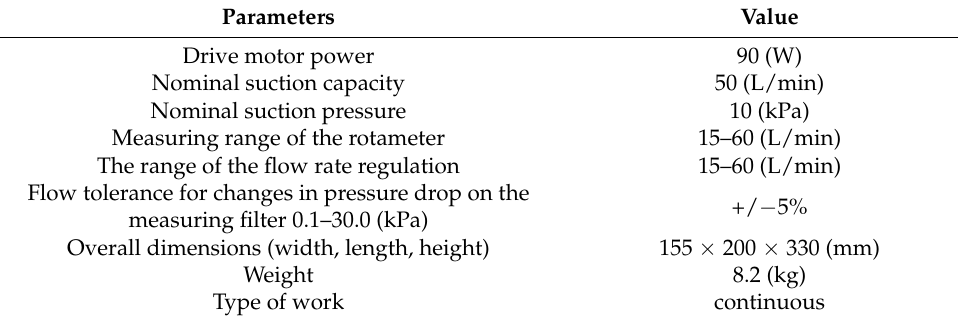
Figure 1. Salt-dust measuring instruments: ( a ) AS-50 gravimetric dust meter; ( b ) U-tube liquid manometer with Pitot–Prandtl probe. Table 1. AS-50 aspirator parameters.